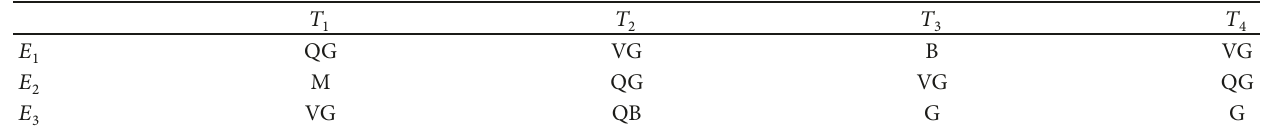
̃𝐿 provided by the expert Ζ 3 .